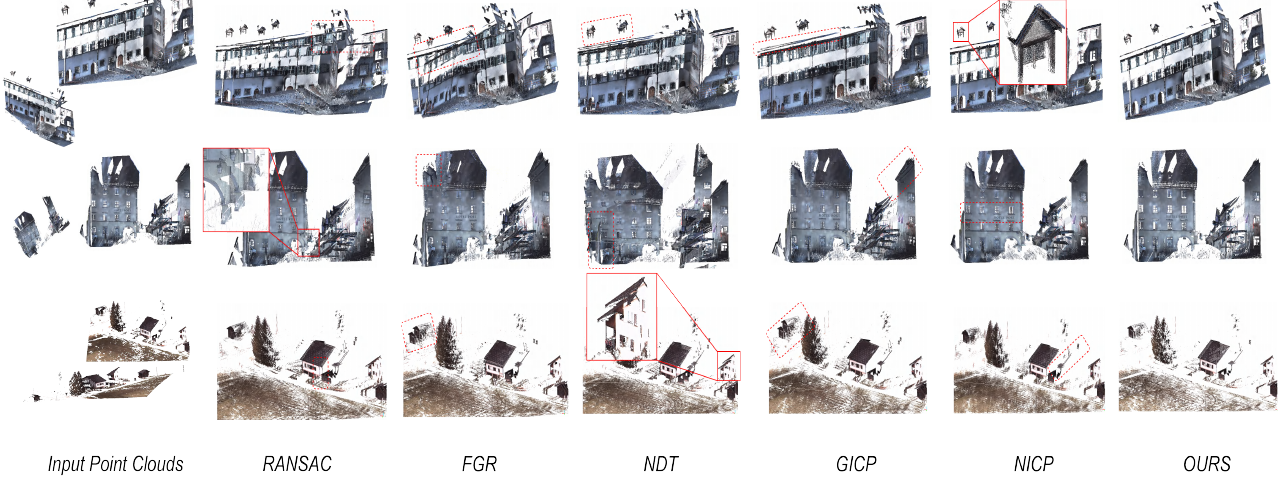
Figure 9. Comparison of registration effects of third-party data. On samples selected from third-party databases (Bird, Dom, and Sg27), we performed point cloud registration tests using RANSAC, FGR, NDT, GICP, NICP, and our proposed method. The dotted box represents the area of the image where there is an obvious deviation in registration, and the square represents the enlarged image of the local